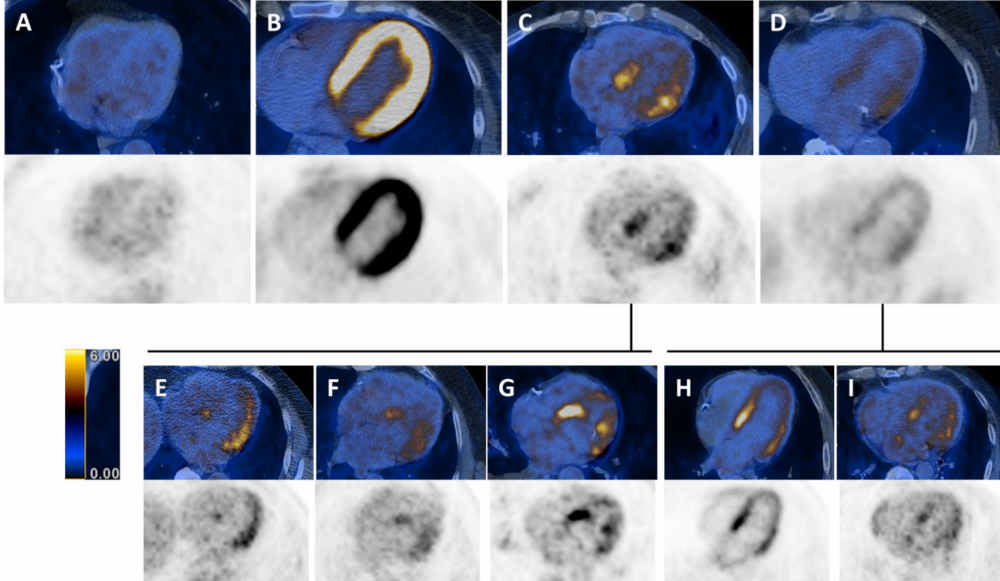
Figure 1. Classification of 18 F-fluorodeoxy-glucose ( 18 F-FDG) uptake patterns in the left ventricular wall. Positron emission tomography (PET) images superimposed on computed tomography (CT) images (colored) and PET images alone (black and white). ( A ) No myocardial 18 F-FDG uptake. ( B ) Di ff use myocardial 18 F-FDG uptake. ( C ) Focal myocardial 18 F-FDG uptake. ( D ) Focal on di ff use myocardial 18 F-FDG uptake. ( E ) Focal over half. ( F ) Focal spot. ( G ) Focal ring. ( H ) Focal on di ff use over half. ( I ) Focal on di ff use